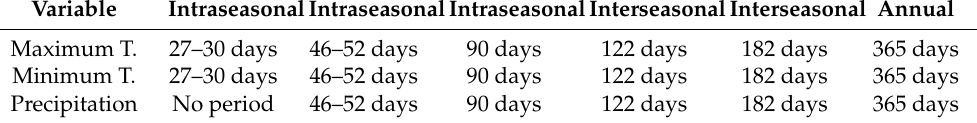
Table 3. Identified periodicities for each meteorological variable in an intraseason, interseason, and annual scales.